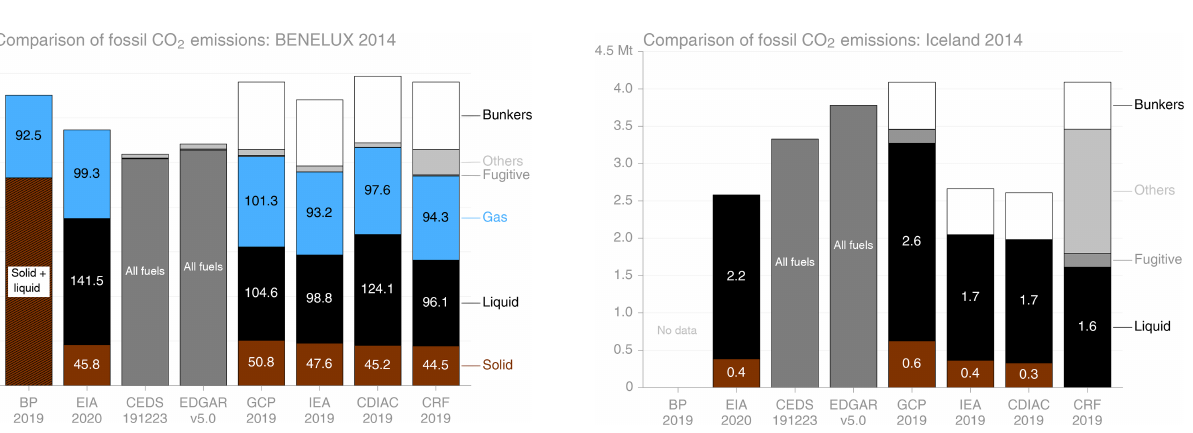
Figure 15. Comparison of fossil CO 2 emissions from six sources for